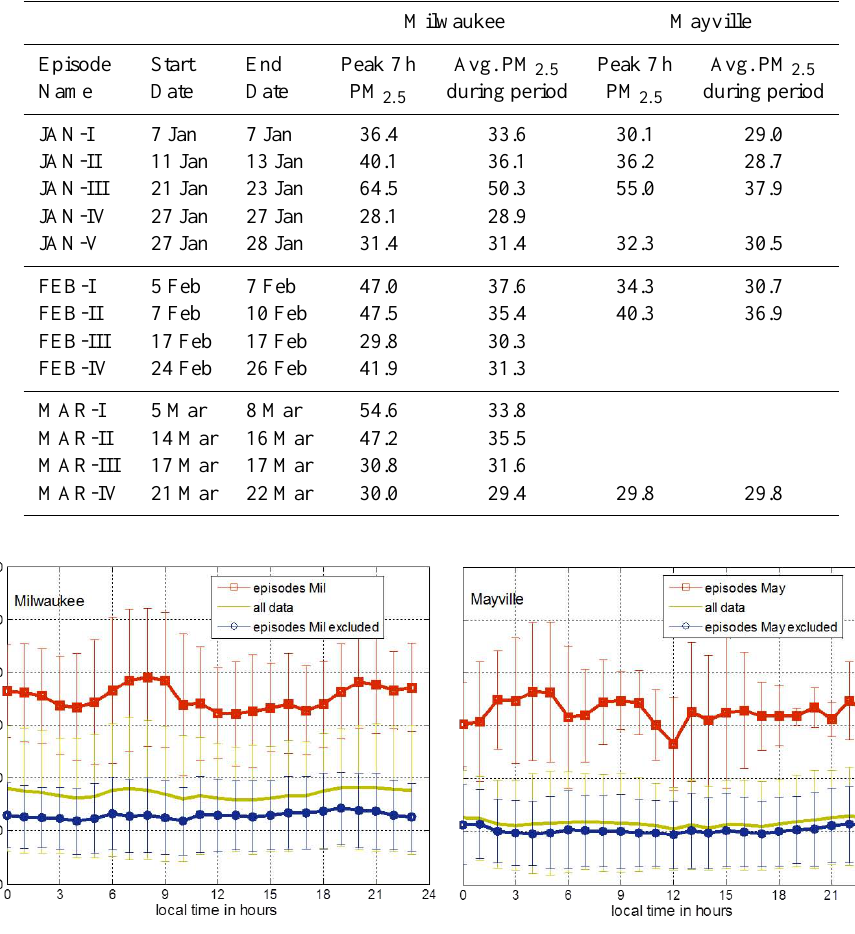
Fig. 4. Diurnal pattern for PM 2 . 5 at Milwaukee (left) and Mayville